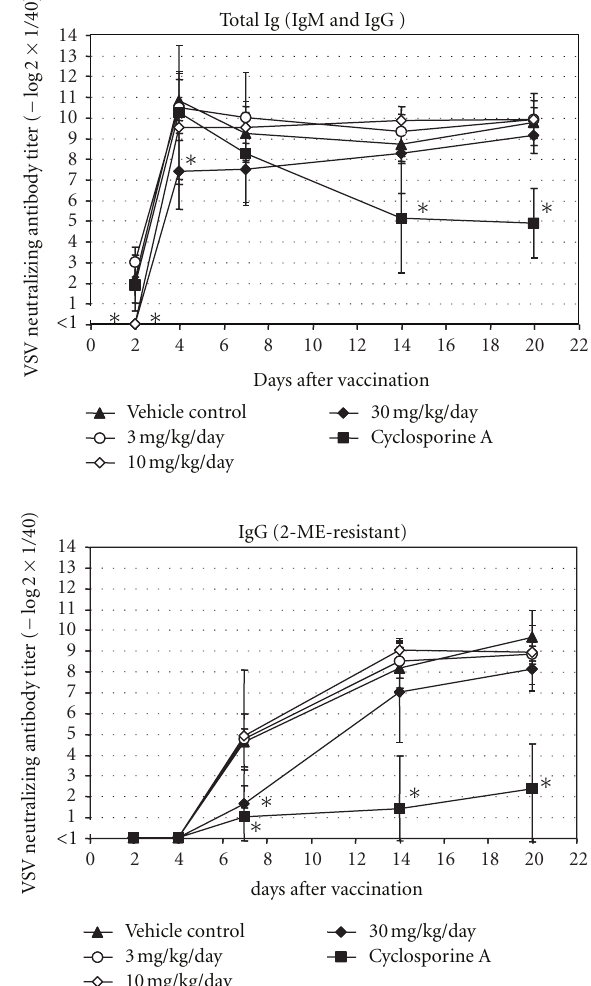
Figure 4: Neutralizing VSV antibodies in mice treated with RO4929097 for 27 days. Neutralizing total Ig ( = IgM + IgG) and IgG antibody titers in serum are shown. For each group, average and standard deviation at di ff erent time points are shown. ∗ = statistically significant di ff erence to vehicle control ( P < 0 . 01) at given time-point. Detection limit of assay was 1 ( = 1/40 dilution of serum). Non-vaccinated mice had no detectable VSV neutralizing antibodies in their serum ( < 1) (not shown). n = 4– 8mice/sex/group.